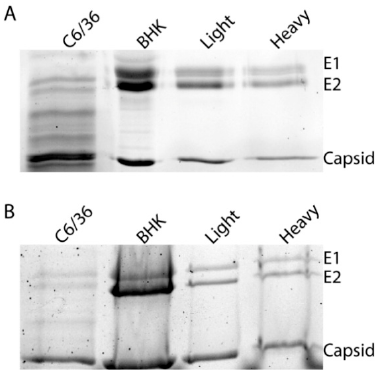
Figure 3. Glycoproteins of SINV subpopulations derived from vertebrate and mosquito cells. Equal number of SINV Light and SINV Heavy virus particles were loaded on a 12% SDS-PAGE and Coomassie staining to assess the migration of E1 and E2 glycoproteins. ( A ) Migration patterns of proteins from particles derived from indicated cell types; ( B ) Migration patterns of proteins from particles following PNGase treatment to remove N-linked glycans.